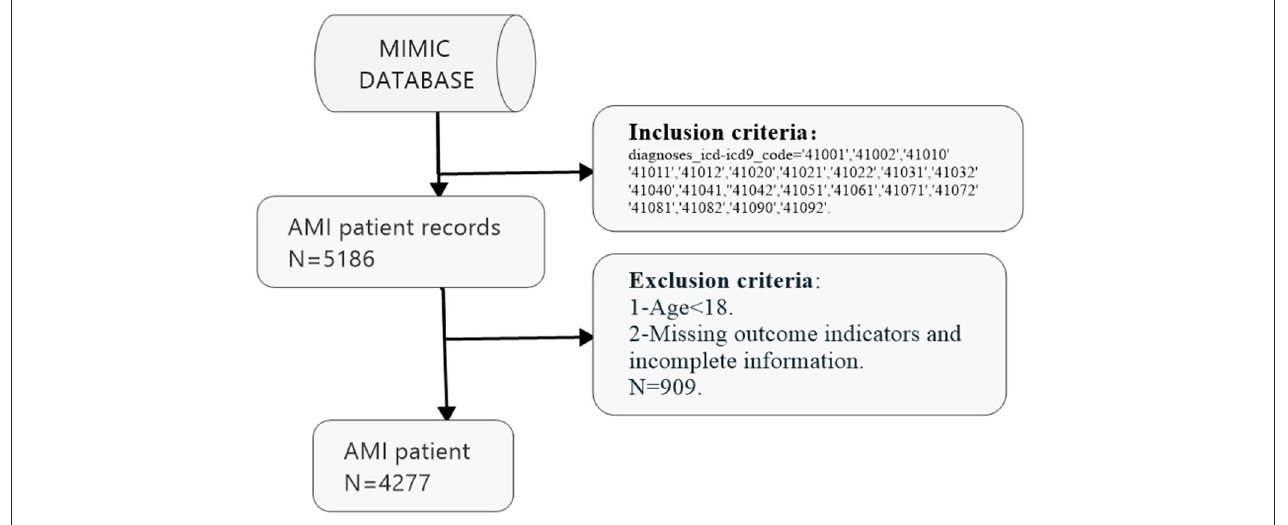
FIGURE 1 | The inclusion and exclusion criteria of this